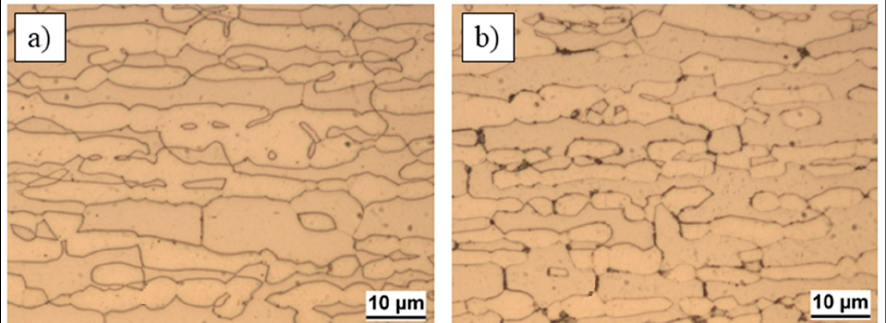
Figure 8. Current density vs. potential curves recorded on as-received and 60 min at 650, 750, and 850 ◦ C aged LDSS 2404 electrodes, by DL-EPR tests in 33 wt.% H 2 SO 4 solution, with 0.9 wt.% HCl, at 20 ◦ C.